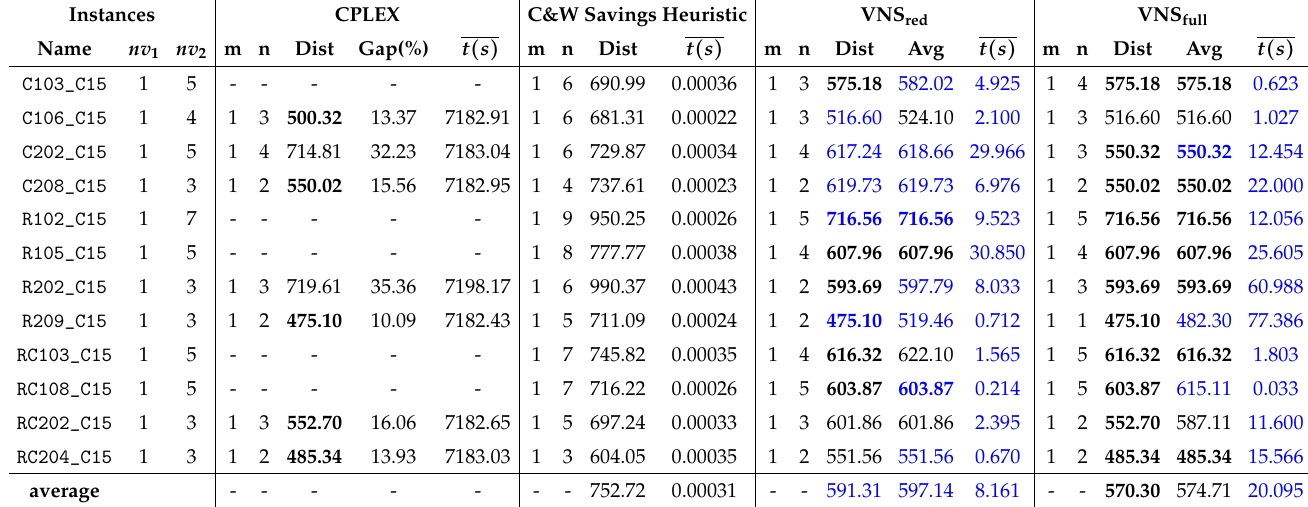
Table 7. Computational results for small-sized instances with 15 customers.